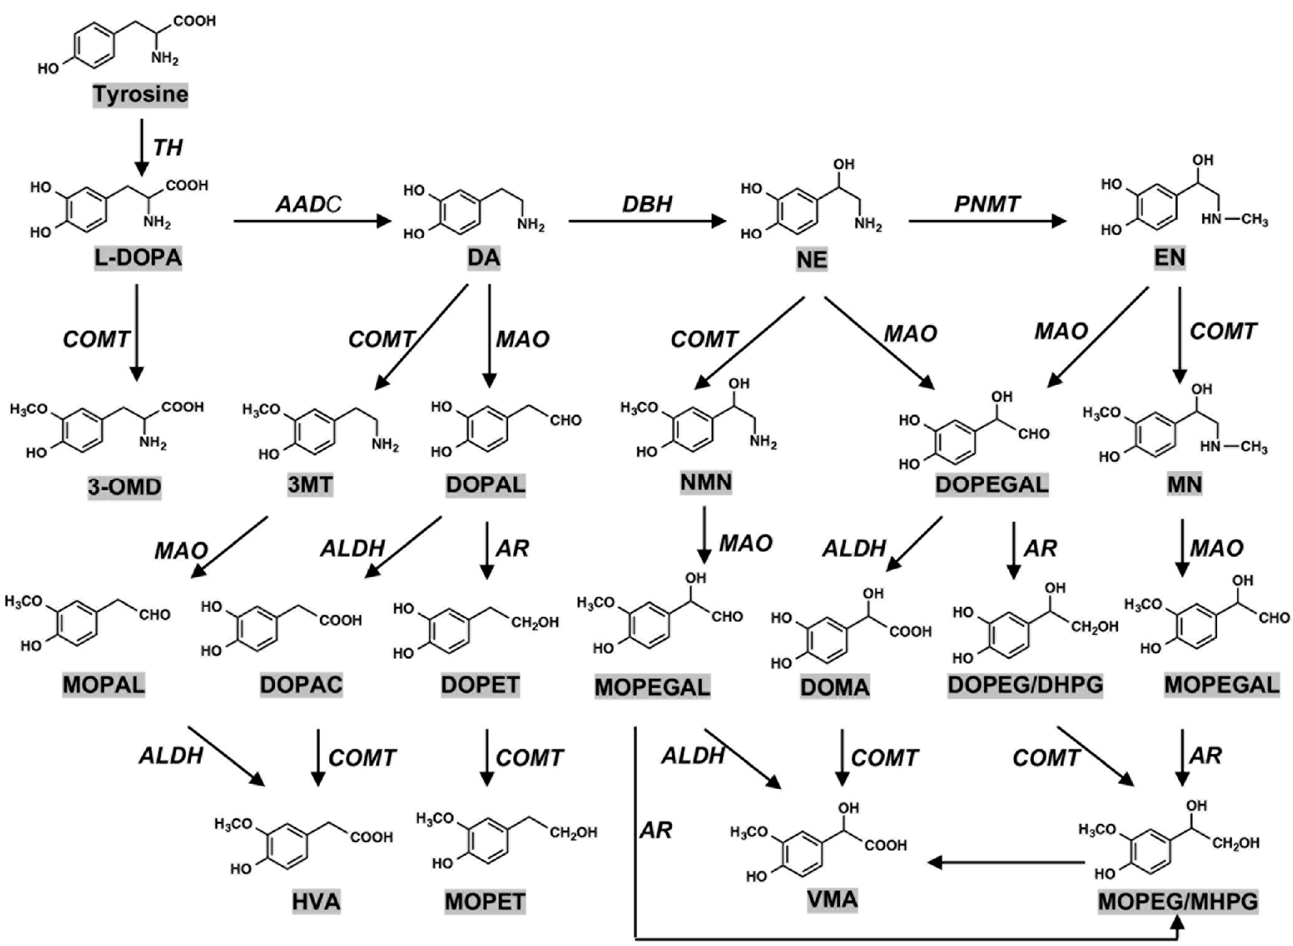
Figure 2. Metabolism of catecholamines. (DOPA) 3,4-dihydroxyphenylalanine; (DA) dopamine; (NE) norepinephrine; (EN) epinephrine; (3-OMD) 3- O -methyldopa; (3MT) 3-methoxytyramine; (DOPAL) 3,4-dihydroxyphenylacetaldehyde; (NMN) normetanephrine; (DOPEGAL) 3,4-dihydrox- yphenylglycolaldehyde; (MN) metanephrine; (MOPAL) 3-methoxy-4-hydroxyphenylacetaldehyde; (DOPAC) 3,4-dihydroxyphenylacetic acid; (DOPET) 3,4-dihydroxyphenylethanol; (MOPEGAL) 3-